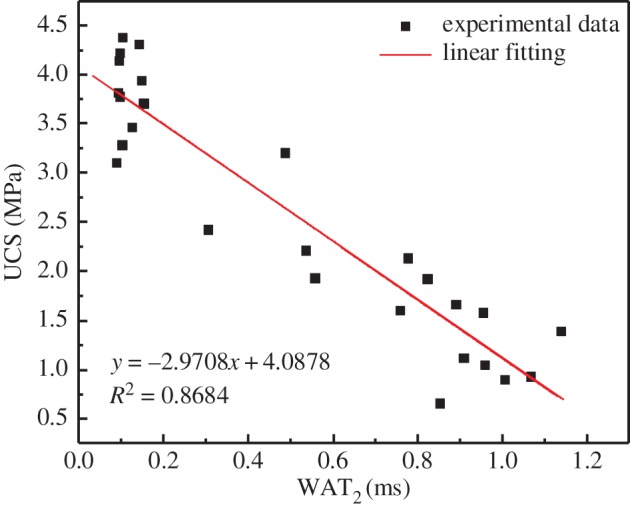
Relationship between UCS and WAT2 value of cemented backfill specimens.